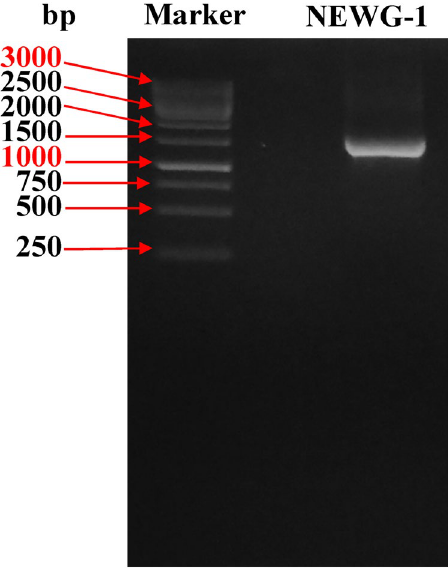
Figure 1. Agarose gel electrophoresis showed the PCR product of the amplified Azotobacter nigricans NEWG-1 16S rRNA fragment.